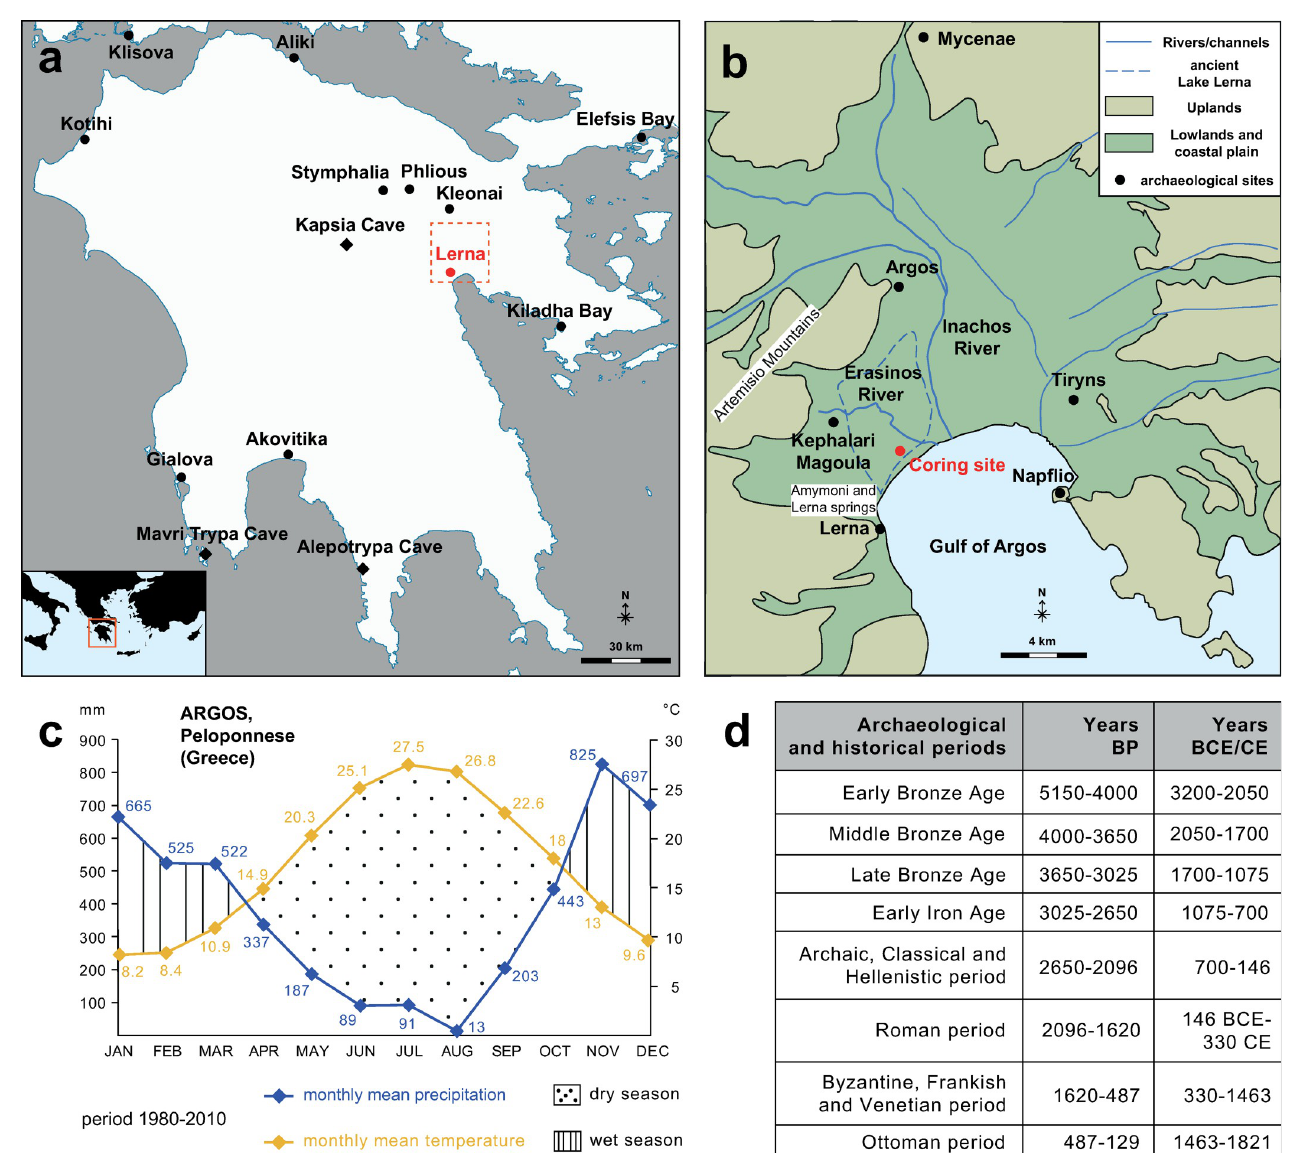
Fig 1. Study area in the Peloponnese (Greece) highlighting the Argive Plain with ancient Lake Lerna and its climatic data, as well as the location of sites for the investigated periods. (a) Location of Lake Lerna and other Peloponnesian sites mentioned in the paper. Dots stand for palaeoenvironmental records, diamonds for palaeoclimatic ones.; (b) Detail of the Argive Plain with the former lake and coring site. The main archaeological and historical sites are shown; (c) Monthly mean temperature (˚C) and precipitation (mm) values recorded in Argos during the period 1980–2010 [32]; (d) Chronology of the main archaeological and historical periods in Greece (from